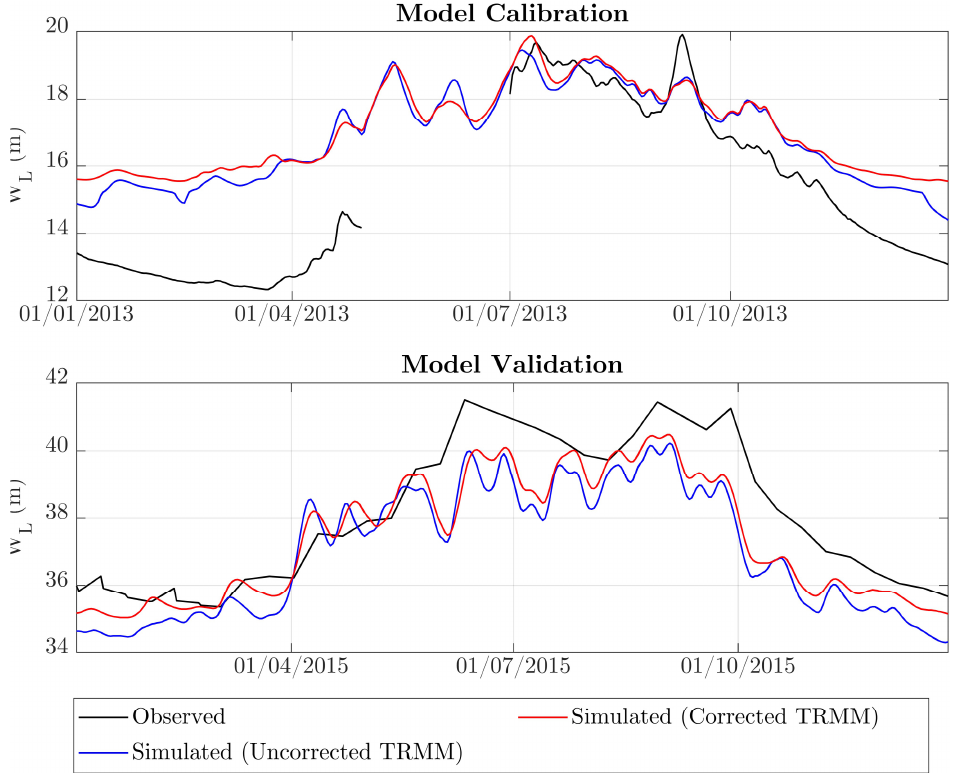
Figure 6. Top: Calibration of the hydraulic model by comparing the water level simulated by the hydraulic model with the water level measured at Bahadurabad. Bottom: Validation of the hydraulic model by comparing the water level simulated by the hydraulic model with the water level estimated from Jason-2 for 2015 for the location near Barpeta.